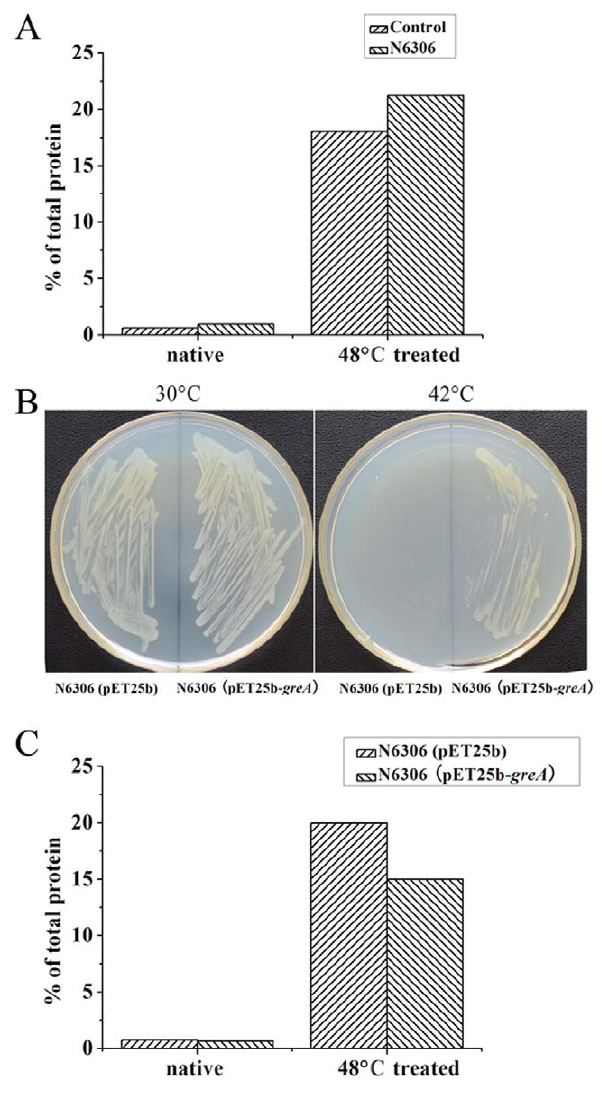
Figure 6. Effect of greA/greB double mutation on cellular aggregation. (A) The greA/greB double mutant strain N6306 suffers extensive aggregation under heat shock. (B) GreA-expression in N6306 suppresses the temperature-sensitive phenotype. (C) GreA-expression in N6306 alleviates cellular aggregation under heat shock.